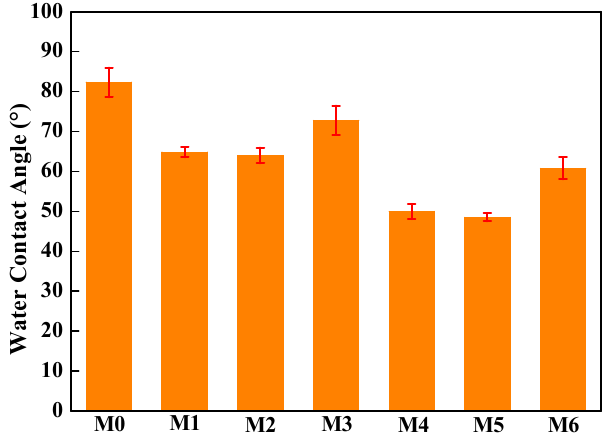
Figure 7. Water contact angle of PVDF composited membranes with oriented or unoriented mCNTs grafting single and diblock chains and membranes with oriented or unoriented mCNTs.